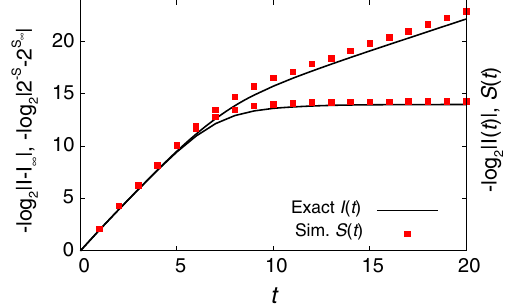
FIG. 25. Exact average results for purity (black curves) are compared with the von Neumann entropy S ð t Þ (red squares). In the upper data, the thermal value is subtracted (left label), while for the lower two saturating sets, it is not (right label). We use n ¼ 30 and the S configuration with PBC and the XXZ gate with a 0 . 5 [the same parameters as in Figs. 10(c) and 10(d)] for z ¼ 2 ln 2 . which the rate is r E ¼